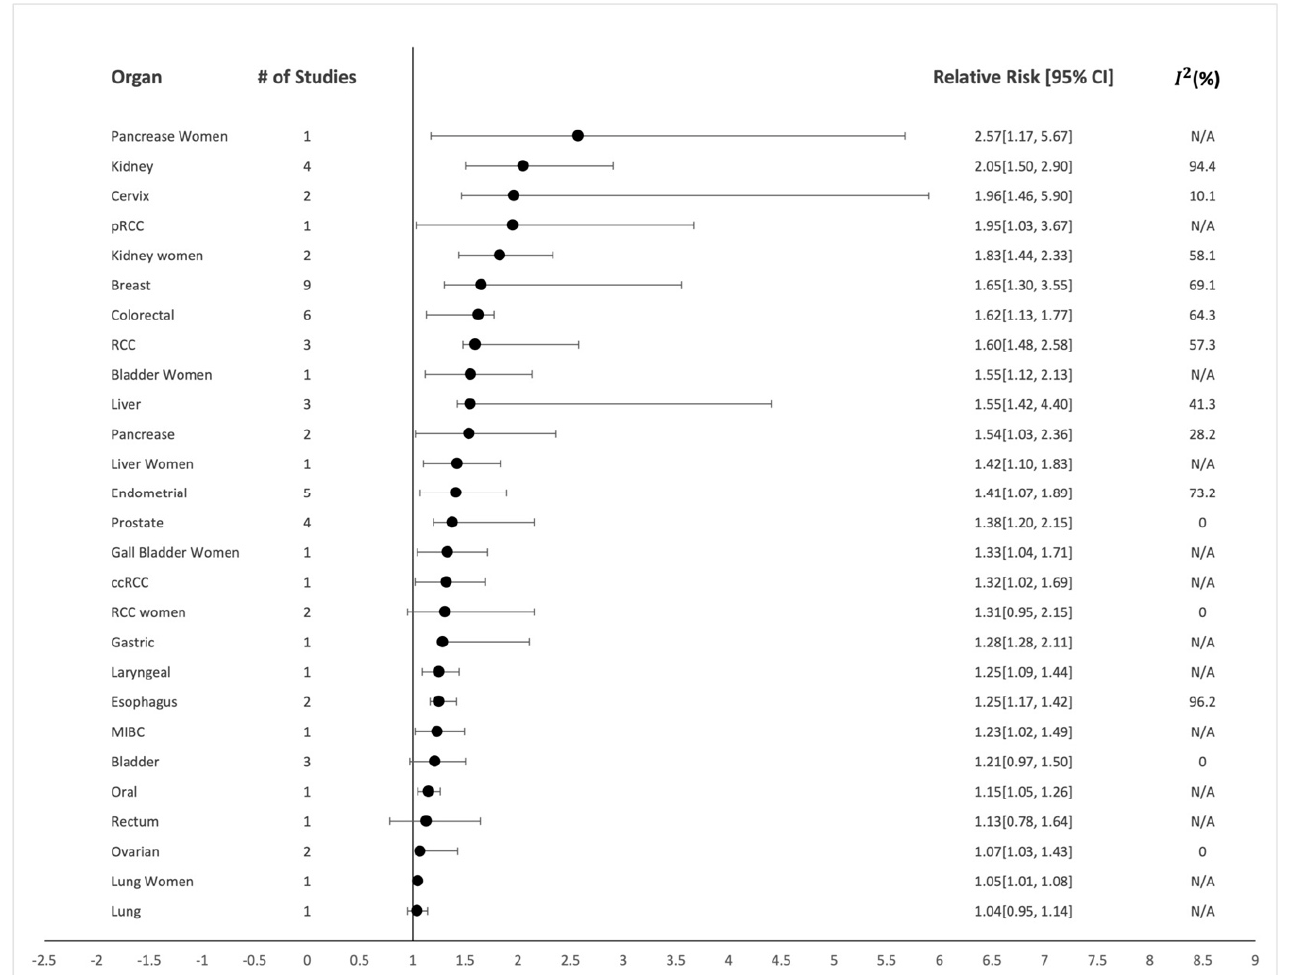
Figure 2. The summary of the relative risks, 95% confidence intervals, and heterogeneity for each individual organ − specific cancer site.